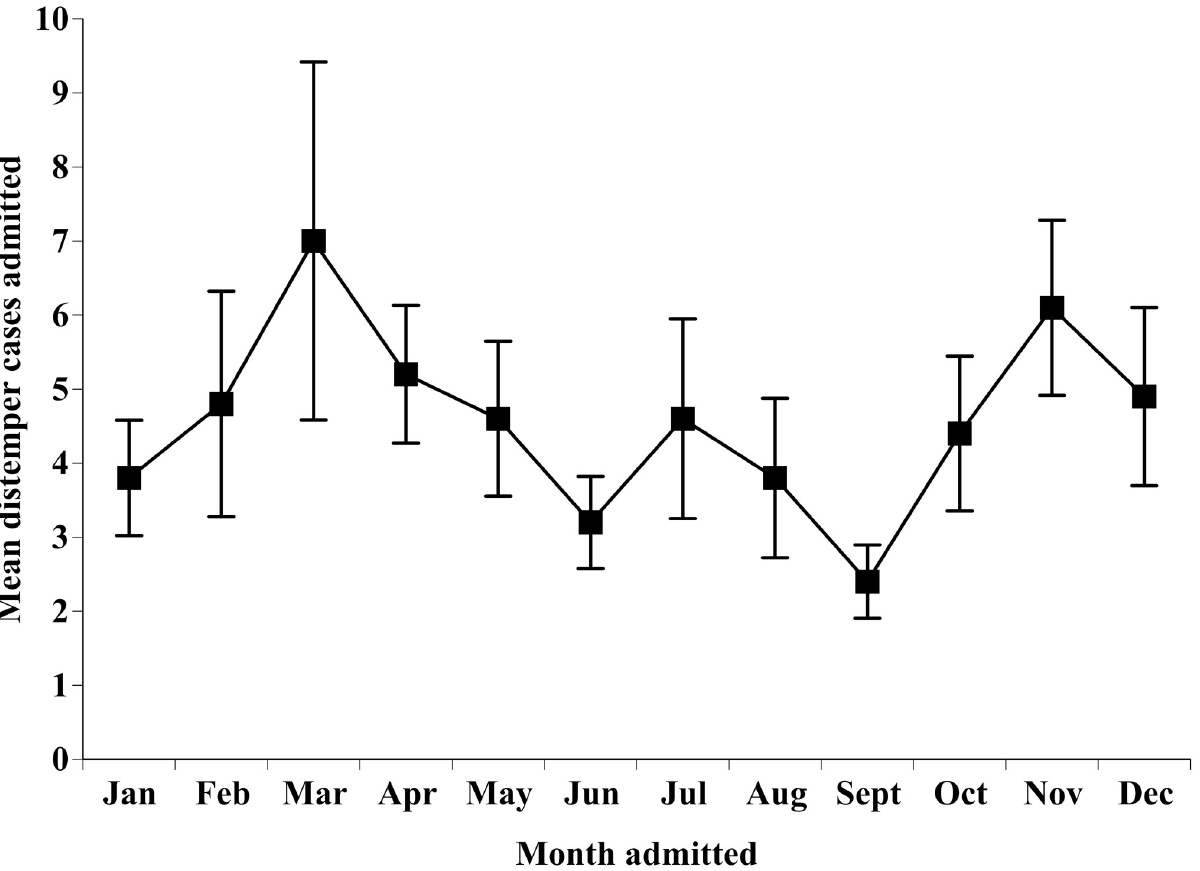
Fig 5. The mean ± SE cases of canine distemper virus admitted per month to the wildlife rehabilitation facility from